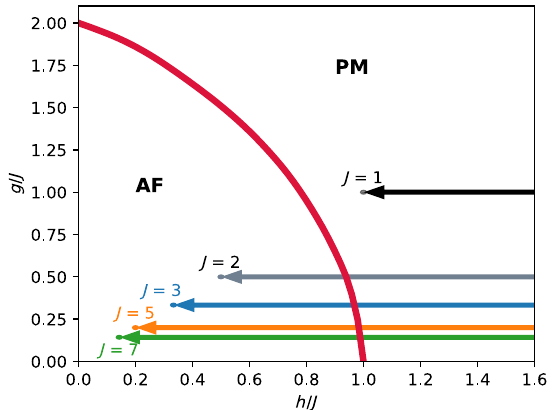
FIG. 7. The zero-temperature phase diagram of the ZZXZ model in the thermodynamic limit. The antiferromagnetic phase (AF) is separated from the paramagnetic phase (PM) by a second- order phase transition (red line). At the multicritical point at ( h , g ) = ( 0, 2 ) , the model becomes classical, resulting in a first- order phase transition. For different interaction strengths J , the adiabatic evolution follows different paths in the phase diagram. The phase diagram is after Ref. [35]: note that their differ- ent Hamiltonian formulation results in an appropriately rescaled phase diagram.